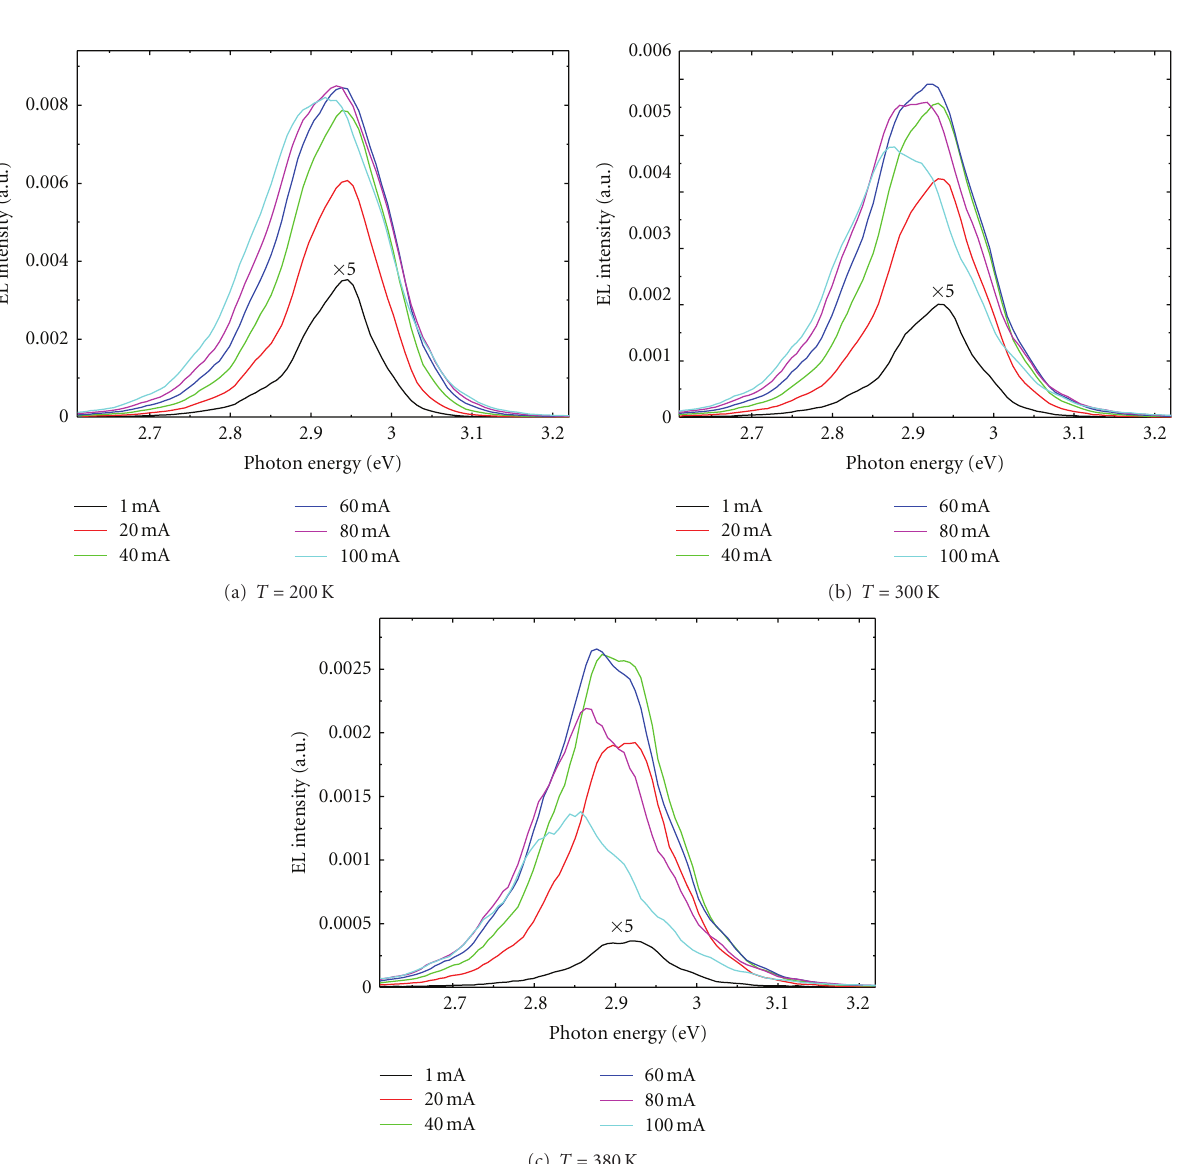
current goes up, especially in the high-temperature region. It implies that the localization e ff ect in the sample with MQBs is evident. The stronger localization e ff ect, together with the higher conduction band discontinuity, lead to the higher EL intensity for the sample with